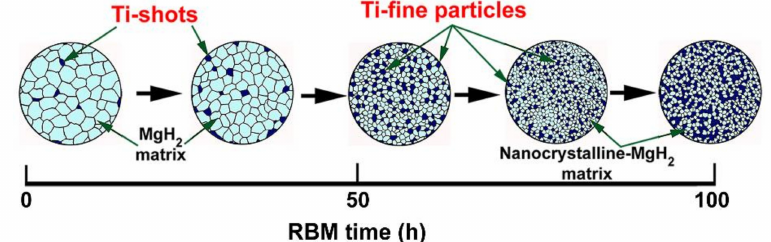
Figure 16. A Schematic presents the e ff ect of RBM time in the reduction of MgH 2 grain sizes. During the RBM process, Ti particles were worn out from the Ti-balls and gradually embedded into the MgH 2 matrix. These spheroid particles that acted as nanocatalytic agent led to improve the hydrogenation / dehydrogenation kinetics of MgH 2